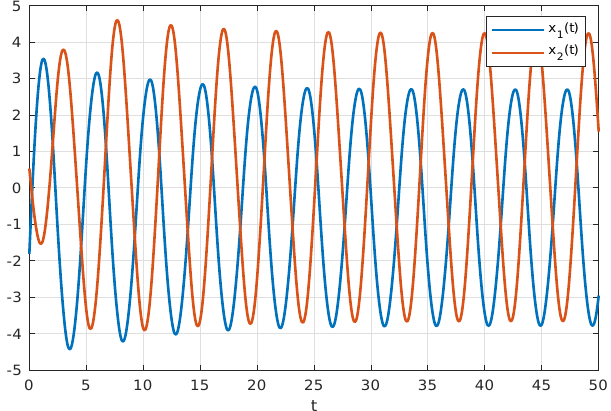
Figure 2. State trajectories of INNs (20) without any control input. Under the designed state-feedback control (7), we chose κ 1 = κ 2 = 6, ι 1 = ι 2 = 1.25 and λ 1 = λ 2 = 10. The fault functions are given as r i ( t ) = 0.9 − 0.1 sin ( t ) , so ˇ r i = 0.8, ˆ r i = 1, i = 1, 2. Based on the above conditions, a = 0.76 and Λ = 3.67 can easily be obtained. Figure 3 shows the state trajectories x 1 ( t ) and x 2 ( t ) of INNs (20) under the given condition (7). The FTS of INNs (20) is successfully realized. On the basis of Theorem 1, it is easy to obtain the settling time T ≤ 1.4974. Hence, Theorem 1 is